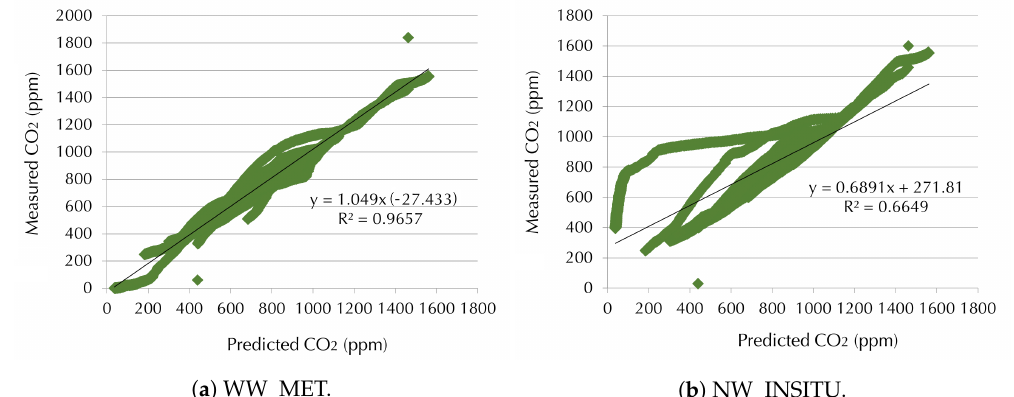
Figure 10. Correlation between predicted and measured CO 2 concentration by IFC models with WW_MET and NW_INSITU in